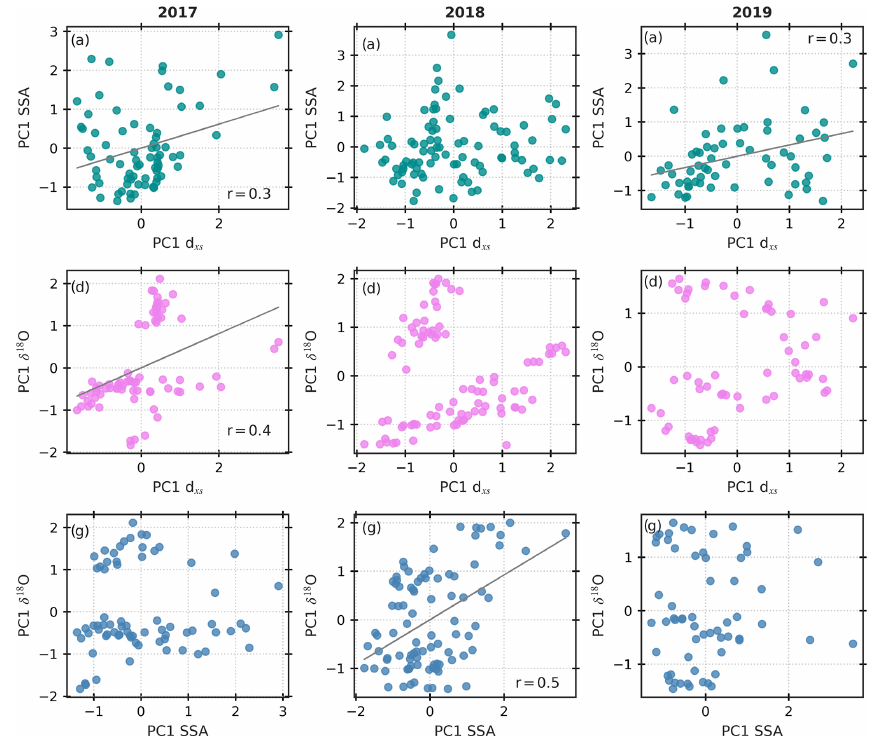
Figure A3. Results from the EOF analysis showing the relationship between SSA, d-excess and δ 18 O in the temporal dimension. Linear regressions are included in plots with significant correlations ( p < 0 . 05) between variables.